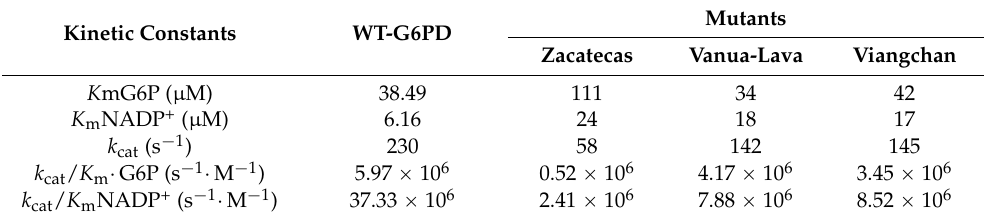
Table 2. Catalytic properties of human G6PD and the